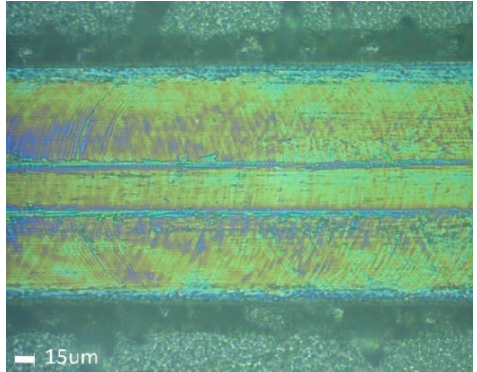
Figure 4. Coating (CF)10 at load of 5.44